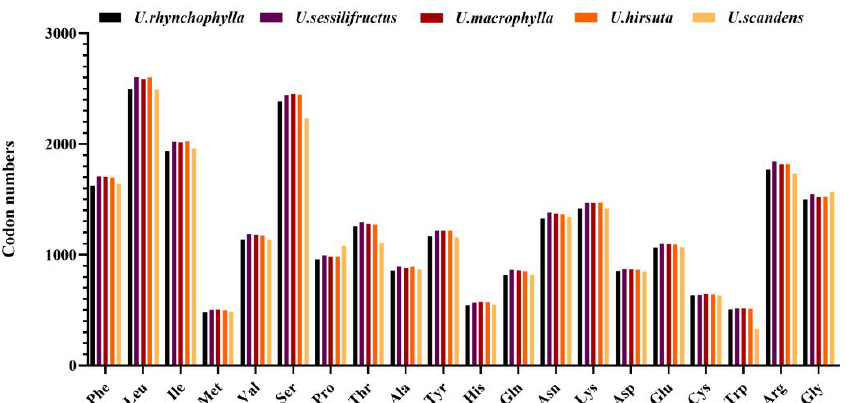
Figure 3. Amino acids and stop codons of codon numbers for the protein-coding regions in five Uncaria species. The histogram from left to right is U. rhynchophylla, U. sessilifructus, U. macrophylla, U. hirsuta, and U. scandens.